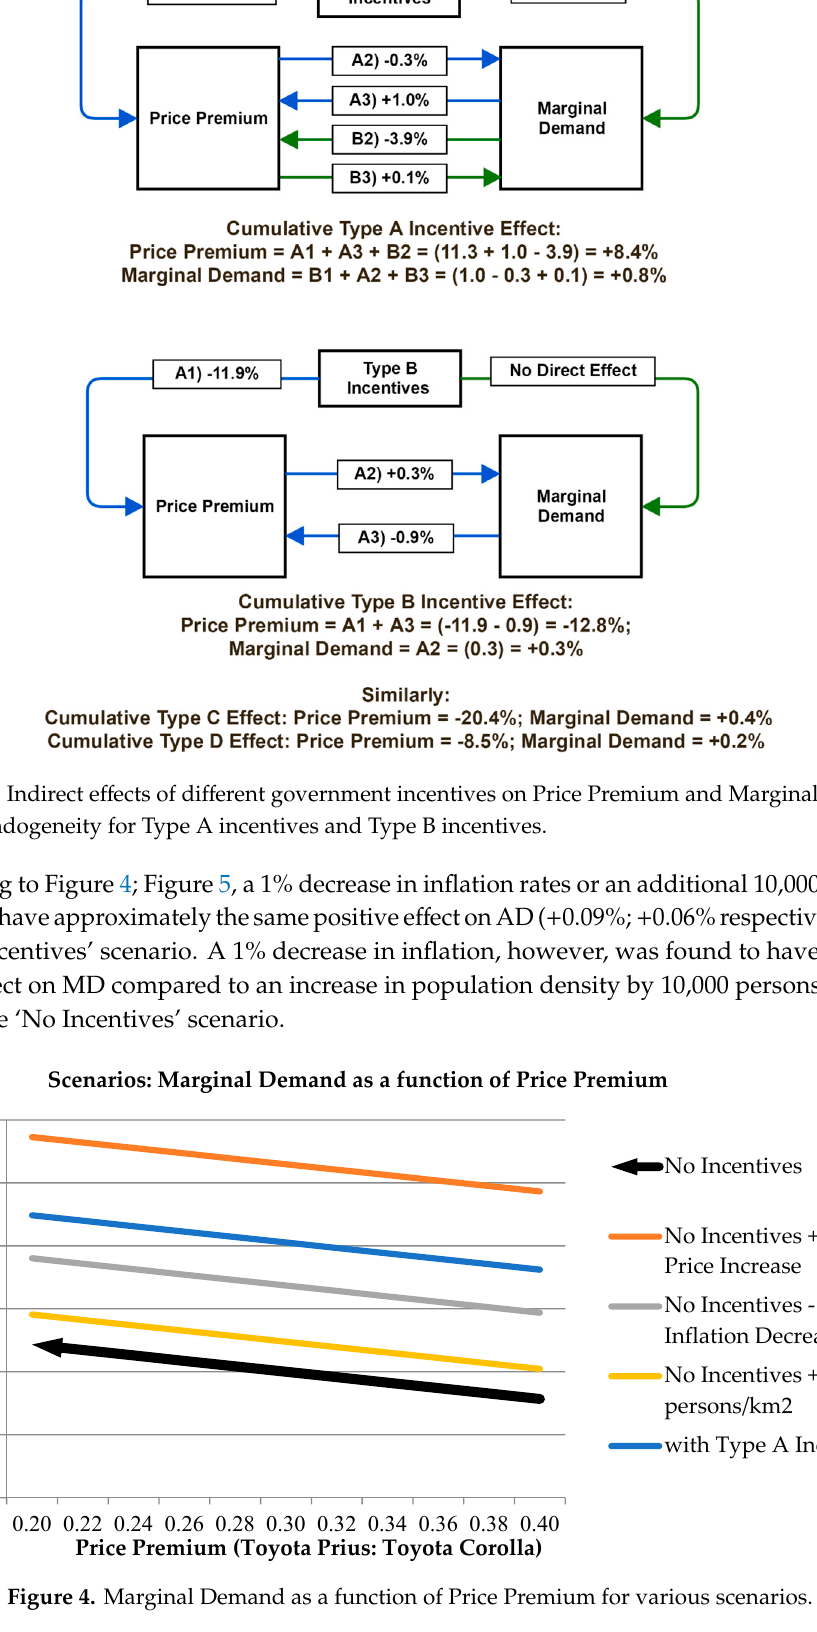
Figure 5. Aggregate Demand as a function of Price Premium for various scenarios . 6. Conclusions In this study we investigated the effects of a range of incentive policies, introduced by governments to encourage the uptake of HEVs, on both the demand for and price of HEVs, using a set of panel data from 2008 to 2012, across 15 regions. A model, using Error-Component Three-Stage Least Squares (EC3SLS) regression, was implemented to estimate a system of equations that included three dependent variables: Annual HEV Marginal Demand (MD); Annual HEV Aggregate Demand (AD) and HEV Price Premium – a proxy for the price ratio between a HEV and a comparable ICE vehicle. This model system allowed the testing of hypothesized endogeneity between HEV price and demand. In order to quantify these relationships, we developed a model system capturing relationships between MD, AD and HEV Price Premium, controlling for the effects of socio-economic factors, and accounting for the effects of four different types of government incentives. One-off subsidies (Type A), such as cash rebates, were found to be associated with higher HEV MD and AD, by 1.4% and 0.3%, on average, respectively. However, Type A policies were also found to be associated with higher HEV price premiums; 11.3% higher, on average. In contrast, purchase cost reduction policies (Type B) were associated with higher HEV AD; by 0.3%, on average, and lower